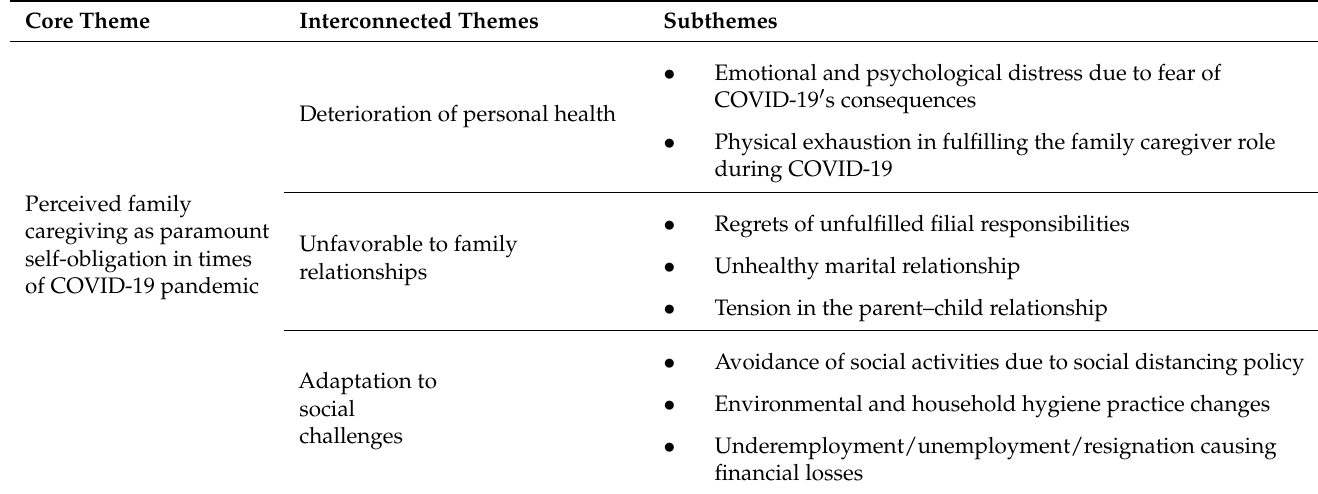
Table 2. The main theme, the three interconnected themes, and the eight